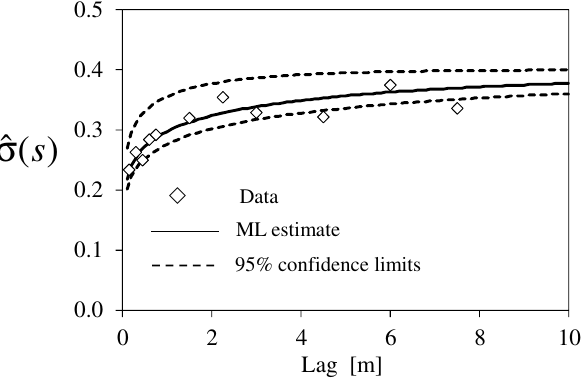
Fig. 12. Experimental scale parameter (diamonds) and their theoret- ical equivalents based on ML fit (solid curve) of TPV (6) based on data from transects D and H (bioturbated sandstone). Dashed curves represent 95% confidence limits of corresponding λ u estimates.